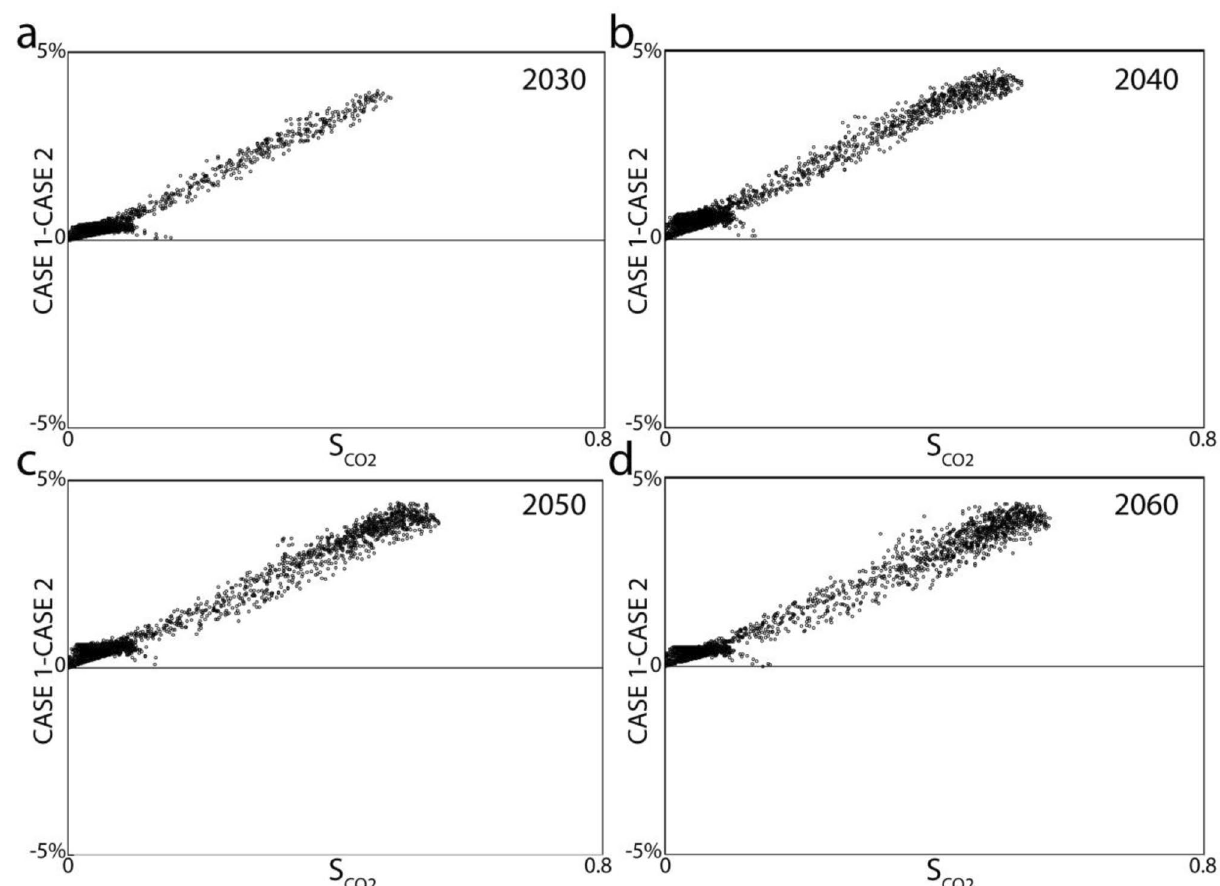
Figure 6. The difference of saturation estimation between Case 1 and Case 2 is plotted against the saturation obtained in Case 1 for years ( a ) 2030, ( b ) 2040, ( c ) 2050, and ( d ) 2060 accordingly. Data points were sampled at regular intervals on the top Sognefjord surface, from which 50% are displayed on the